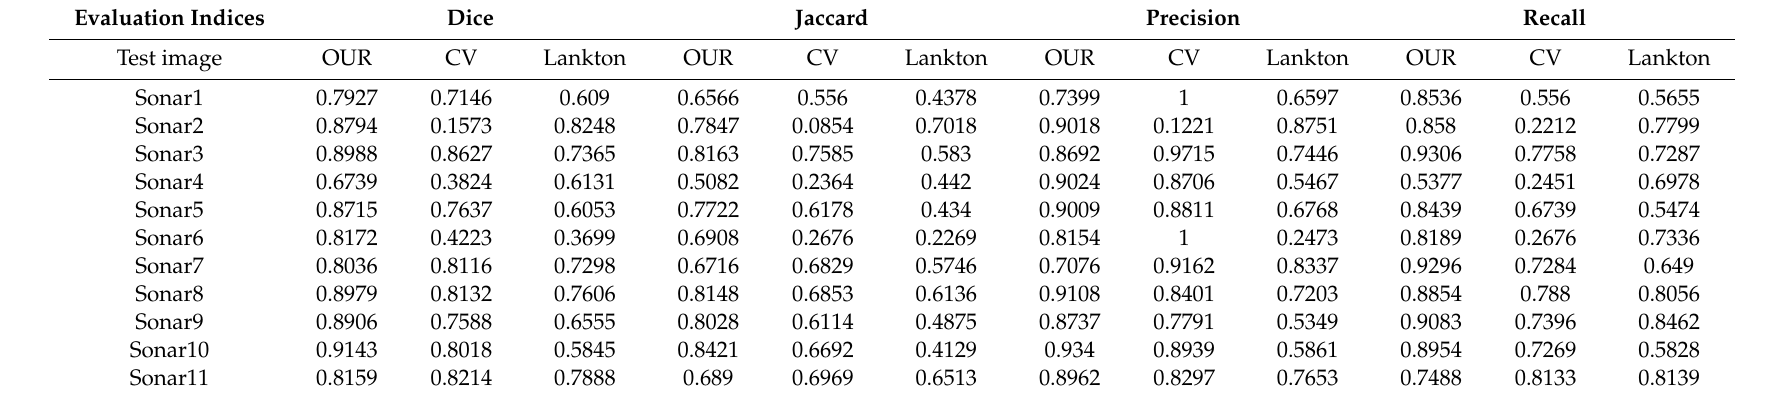
Table 3. Evaluation results (with the pixels test image that was used normalized to 128 ×